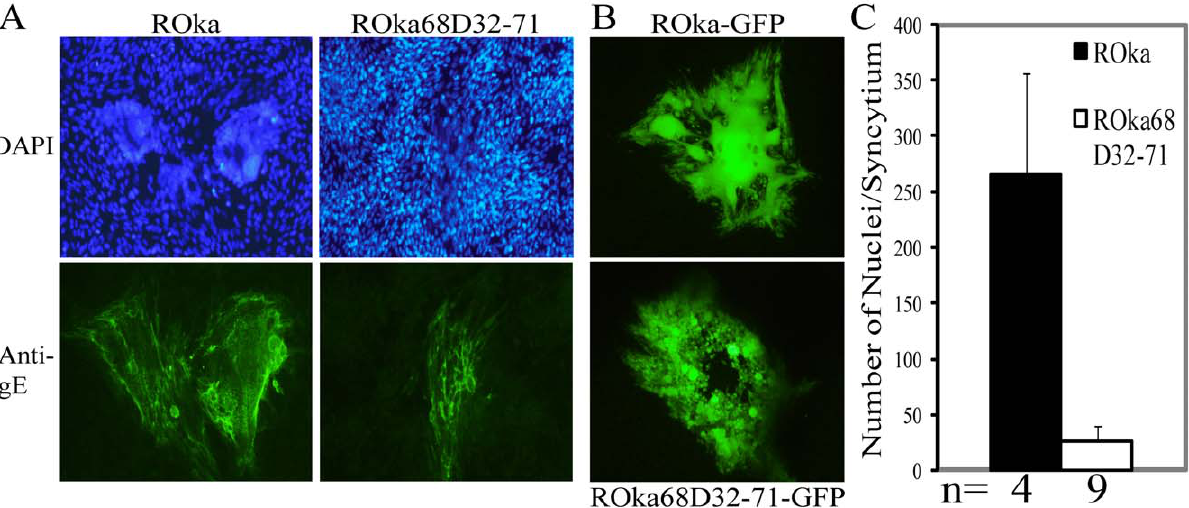
Figure 8. VZV mutants deleted for the IDE binding domain of gE are impaired for syncytia formation. (A) Melanoma cells were infected with VZV ROka or ROka68D32-71 and stained with DAPI (top panels) or mouse monoclonal antibody to gE followed by anti-mouse-Alexa-488 and visualized by immunofluorescence microscopy. Magnification 40X. (B) Melanoma cells were infected with VZV ROka-GFP or ROka68D32-71-GFP and visualized directly by fluorescence microscopy. Magnification 40X. (C) Quantification of the number of nuclei in syncytia per nucleus was performed using confocal microscopy (Leica SP2, Leica Microsystems, Exton, PA). Sequential Z-sections of DAPI stained infected cells were acquired for 3D reconstruction of representative cells with Imaris software (version 6.2, Bitplane AG, Zurich, Switzerland). The numbers of nuclei were automatically determined using spot function in Imaris software and manually corrected for errors by independent investigators in Biological Imaging, Research Technologies Branch, NIH. Vertical lines show standard deviations. n represents the number of syncytia analyzed in which nuclei were counted by a microscopist who was unaware of the expected outcome of the experiment.